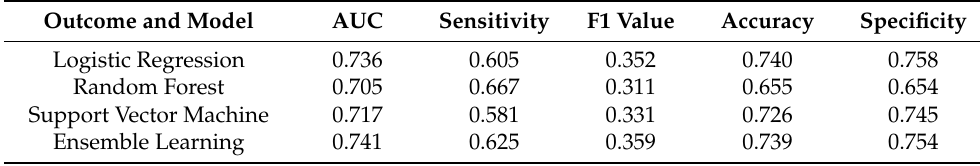
Table 2. Prediction performance of these models in the test